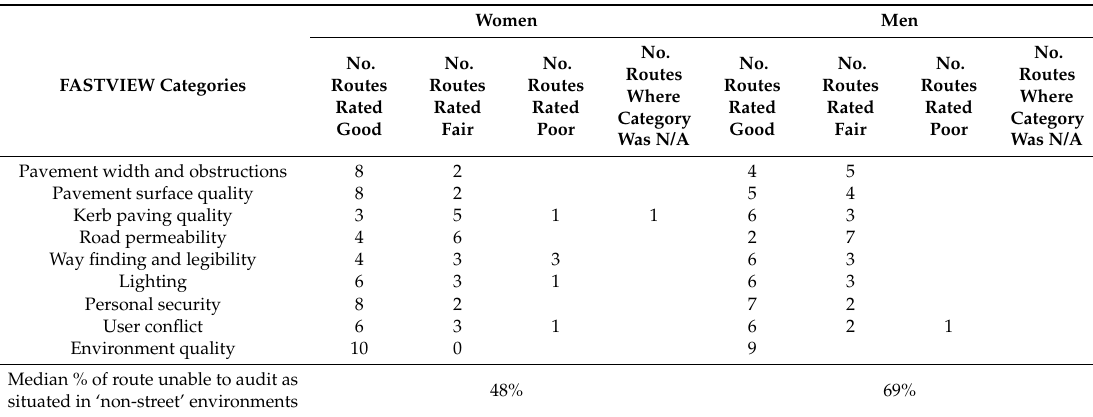
Table 3. Route walkability scores by